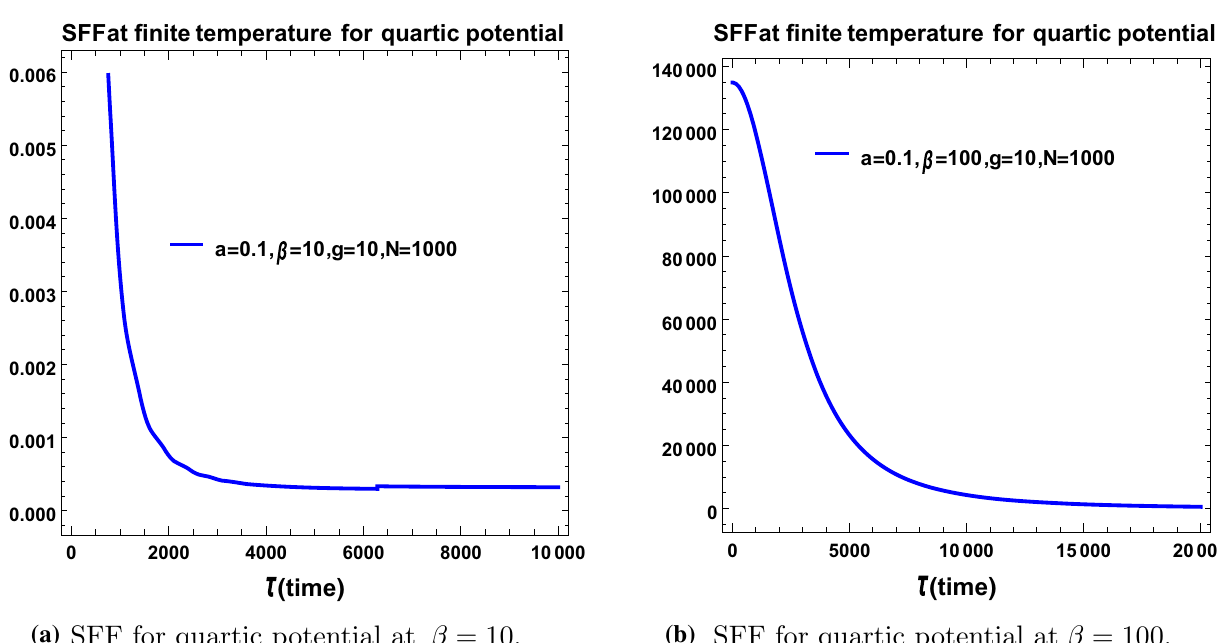
Fig. 26 Spectral Form Factor for quartic potential at different finite temperature[ β ] with N = 1000 and a = 0 .